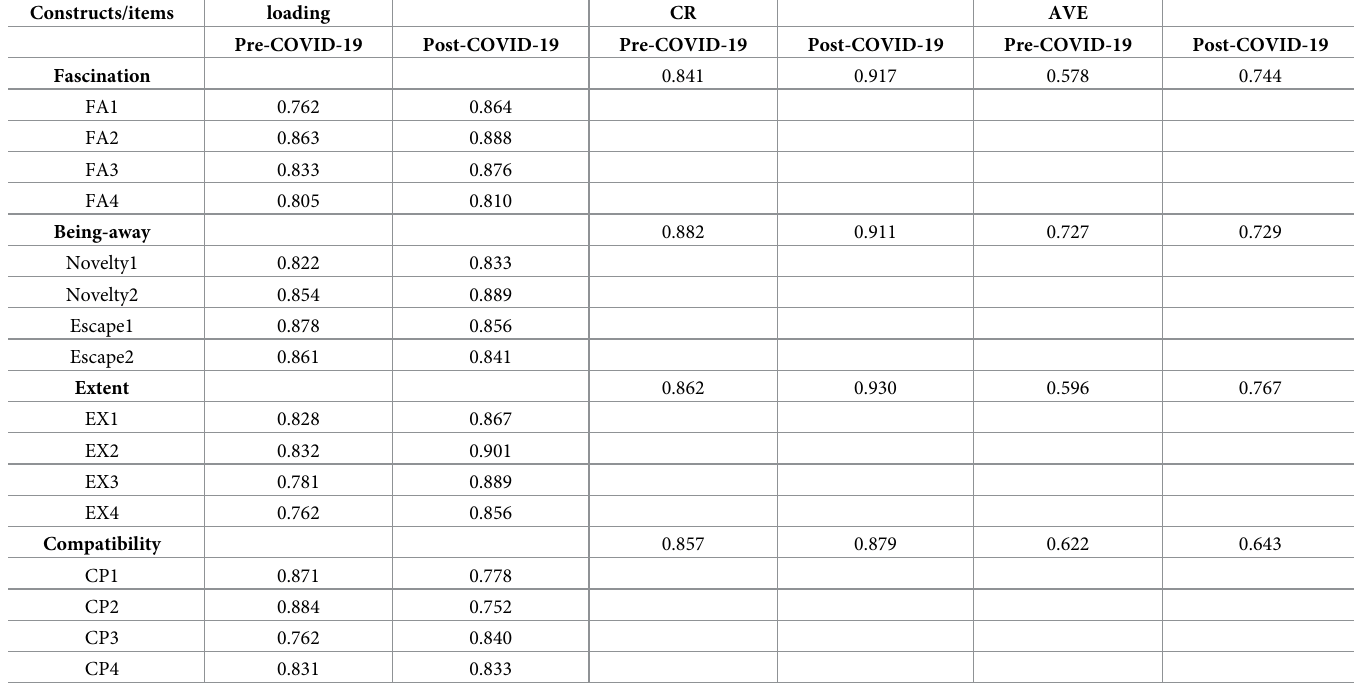
Table 1. Individual item reliability and construct